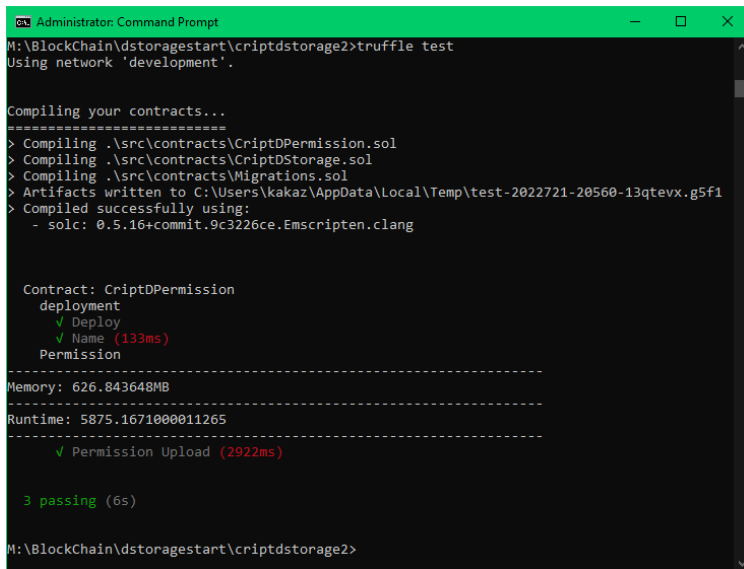
Figure 3. Result of running a test.